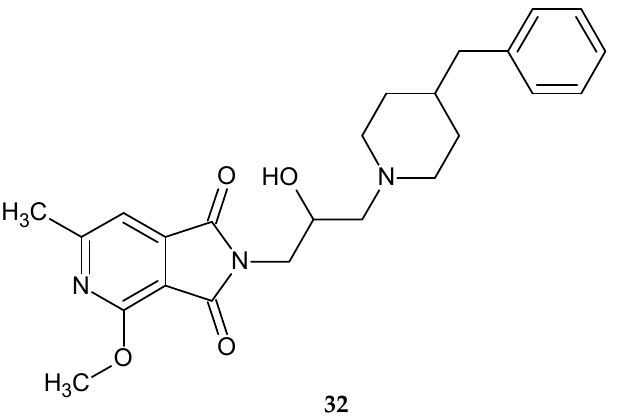
Figure 26. 2-[2-hydroxy-3-(4-benzyl-1-piperidinyl)propyl]-4,6-dimethyl-1 H -pyrrolo[3,4- c ]pyridine- Figure 26. 2 ‐ [2 ‐ hydroxy ‐ 3 ‐ (4 ‐ benzyl ‐ 1 ‐ piperidinyl)propyl] ‐ 4,6 ‐ dimethyl ‐ 1 H ‐ pyrrolo[3,4 ‐ c ]pyridine ‐ 1,3(2 H )-dione 32 1,3(2 H ) ‐ dione 32 . Figure 26. 2 ‐ [2 ‐ hydroxy ‐ 3 ‐ (4 ‐ benzyl ‐ 1 ‐ piperidinyl)propyl] ‐ 4,6 ‐ dimethyl ‐ 1 H ‐ pyrrolo[3,4 ‐ c ]pyridine ‐ 1,3(2 H ) ‐ dione 32 .